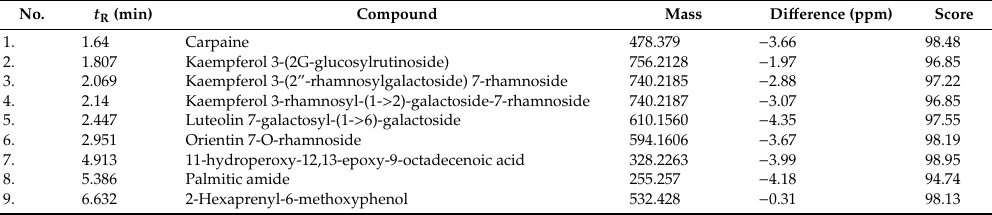
Table 5. Mass spectral analysis of the compounds present in the extract of C. papaya leaves using the reflux